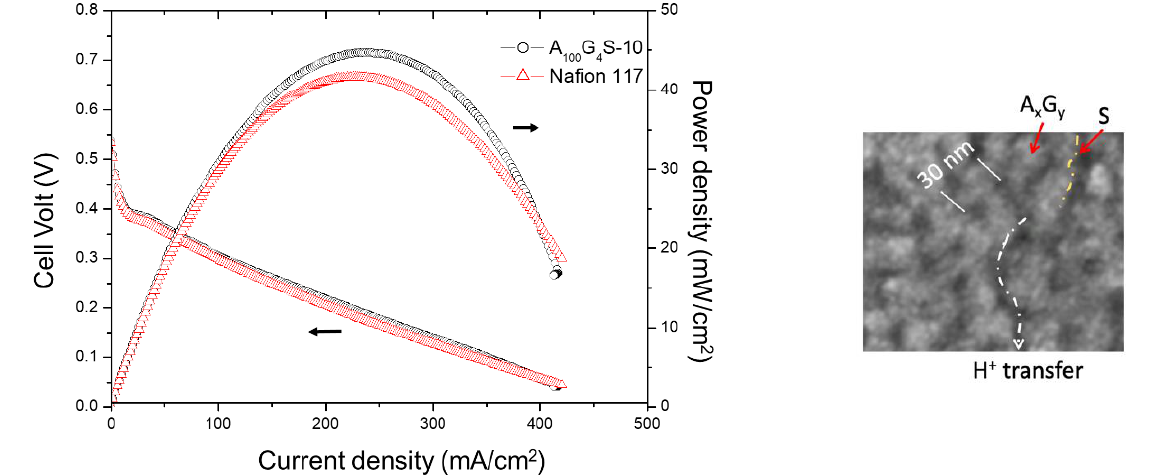
Figure 12. Performance of the A 100 G 4 S-10 cross-linked diblock ionomer membrane electrode assembly (MEA) and a Nafion 117 MEA tested in a DMFC running at 30 °C with a 4.0 M methanol feed (flow rate: 5 cc/min for MeOH and 50 cc/min for dry oxygen). Inset: showing the influence of microstructure on the cell performance.